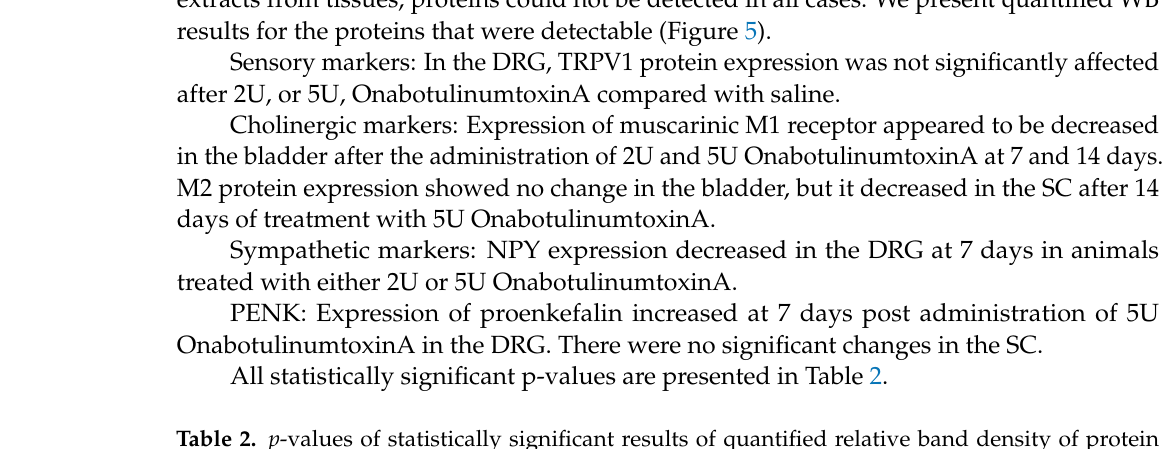
Table 2. p -values of statistically significant results of quantified relative band density of protein analysis by